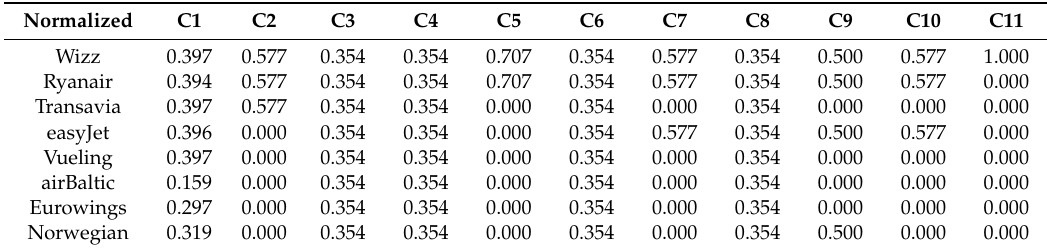
Table A2. Full calculations of the LCC criteria TOPSIS.